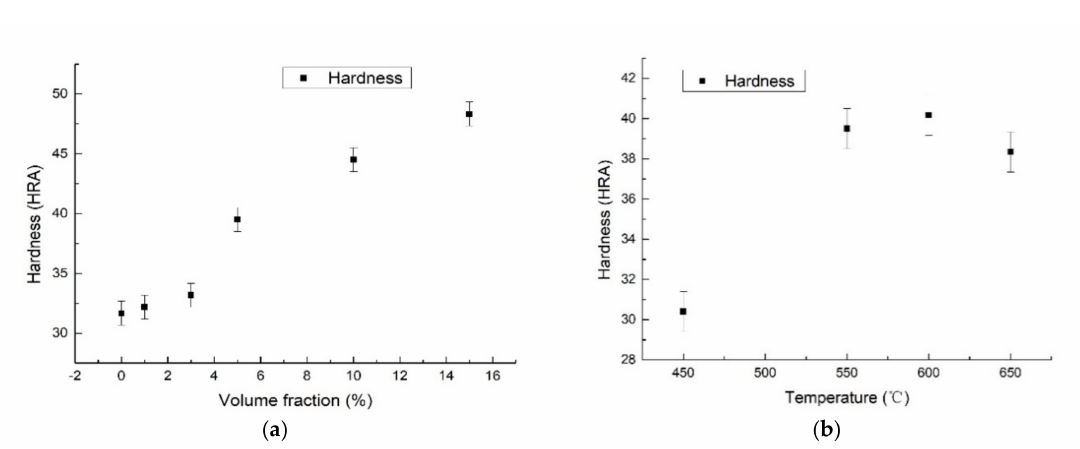
Figure 12. The curve of the hardness of AA6061 / N-SiCp composite at 4.5 GPa: Relationship between hardness and volume fraction: 0, 1, 3, 5, 10, 15 vol.% ( a ), Relationship between hardness and sintering temperature: 450, 550, 600, 650 ◦ C ( b ) for AA6061 / 5 vol.% N-SiCp